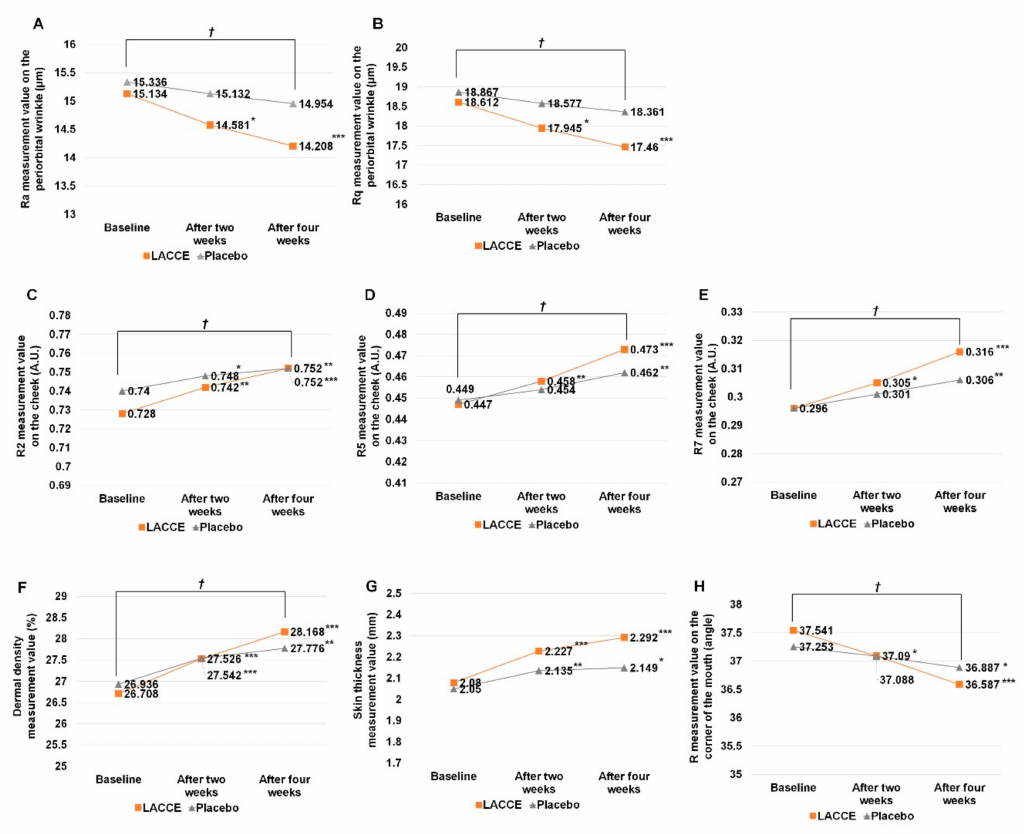
Figure 4. In vivo clinical tests of LACCE for facial lifting and improving periorbital wrinkles, skin elasticity, dermal density, and skin thickness. Ra ( A ) and Rq ( B ) values were measured by the PRIMOS high-resolution system at three di ff erent time points to observe periorbital wrinkle e ff ect of LACCE (1%). Gross elasticity (R2) ( C ), net elasticity (R5) ( D ), and biological elasticity (R7) ( E ) values were measured to observe skin elasticity with LACCE. Measurement of dermal density ( F ) and skin thickness ( G ). R measurement at corner of mouth ( H ). Before / after: probability p (repeated measures ANOVA, significant: * p < 0.05, ** p < 0.01, *** p < 0.001). LACCE / Placebo B: probability p (repeated measures ANOVA, significant: † p <